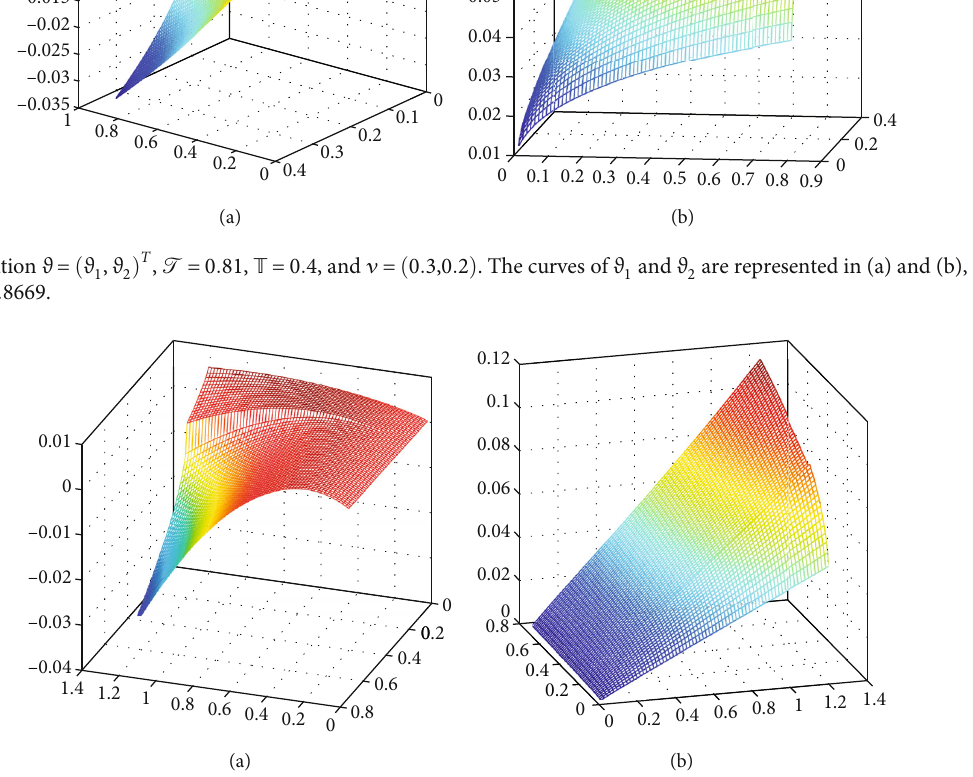
, ϑ T , T = 0 : 81 , T = 0 : 4 , and ν = ð 0 : 3,0 : 2 Þ . The curves of ϑ 1 2 Þ